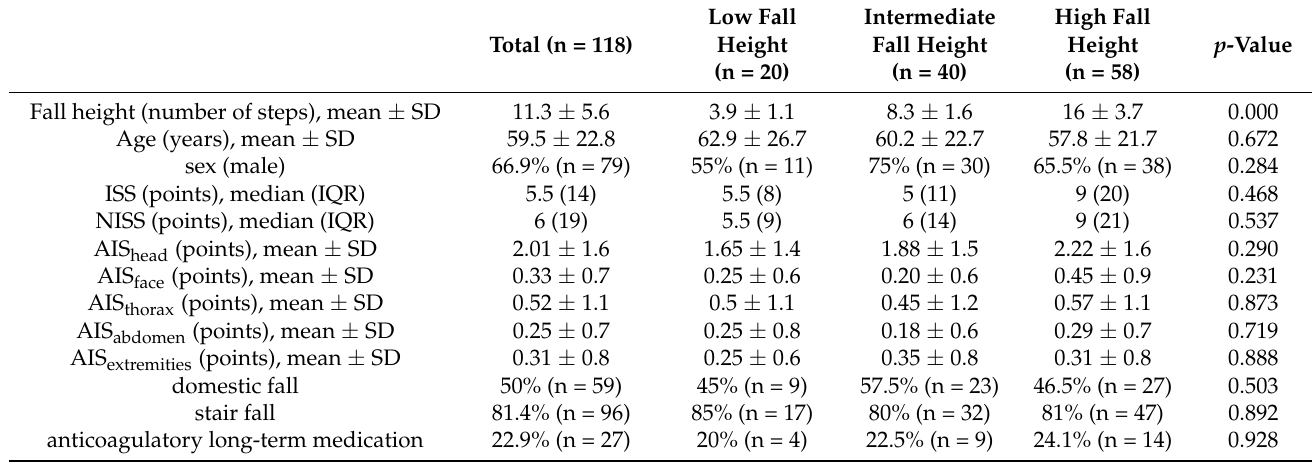
Table 1. Demographic data.